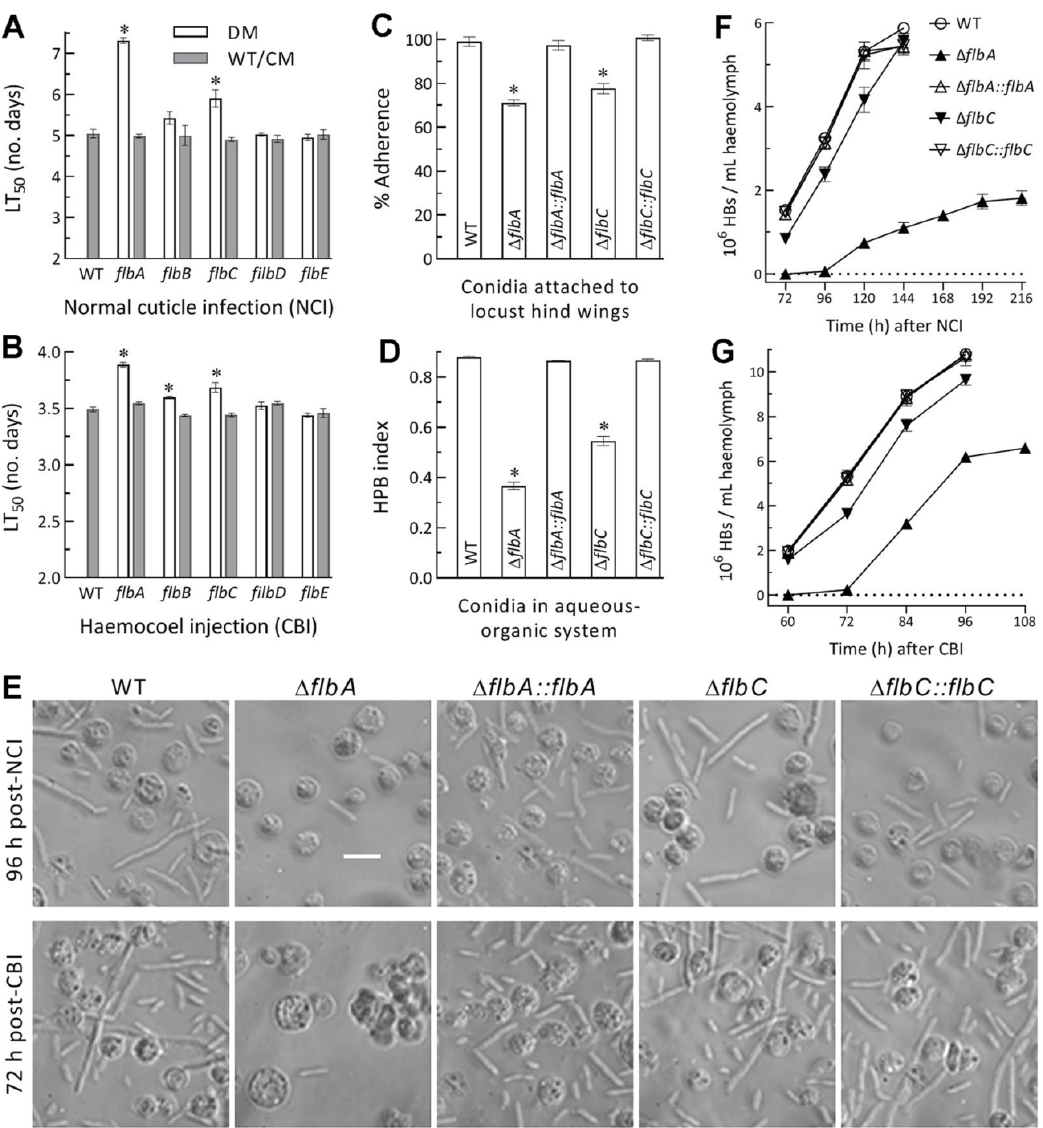
Figure 4. Virulence and related cellular events of Δ flb mutants (DM) and control (WT and CM) strains in B. bassiana . ( A , B ) LT 50 s (d) estimated by fitting the time-mortality trends of G. mellonella larvae after topical application (immersion) of a 10 7 conidia/mL suspension for normal cuticle infection (NCI) and intrahemocoel injection of ~500 conidia per larva for cuticle-bypassing infection (CBI), respectively. ( C ) Conidial adherence to locust hind wing cuticle assessed as percent ratios of post-wash versus pre-wash counts with respect to the WT standard. ( D ) Conidial hydrophobicity (HPB) index quantified in an aqueous-organic system. ( E ) Microscopic images (scale bar: 20 μ m) for the status of hyphal bodies (HBs; slender cells) and host hemocytes (spherical or subspherical cells) in the hemolymph samples taken from surviving larvae 120 h post-NCI and 72 h post-CBI. ( F , G ) Concentrations of hyphal bodies in the hemolymph samples taken over the time after NCI and CBI, respectively. * p < 0.05 in Tukey’s HSD tests. Error bars: SDs of the means from three independent replicates .